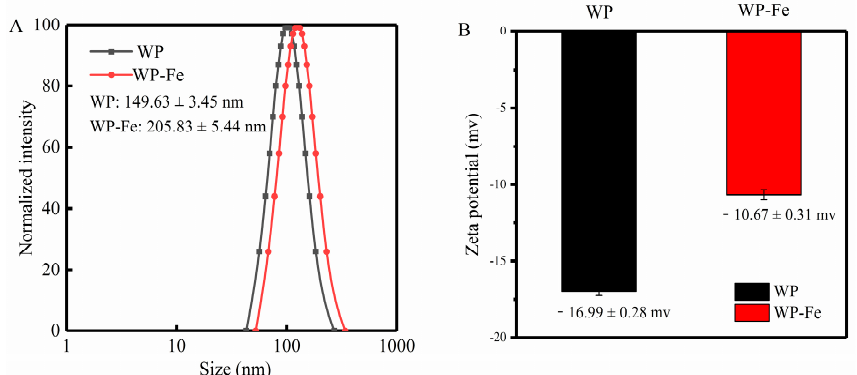
Figure 2. Particle size distribution ( A ) and zeta potential ( B ) of the WP and WP-Fe chelate.